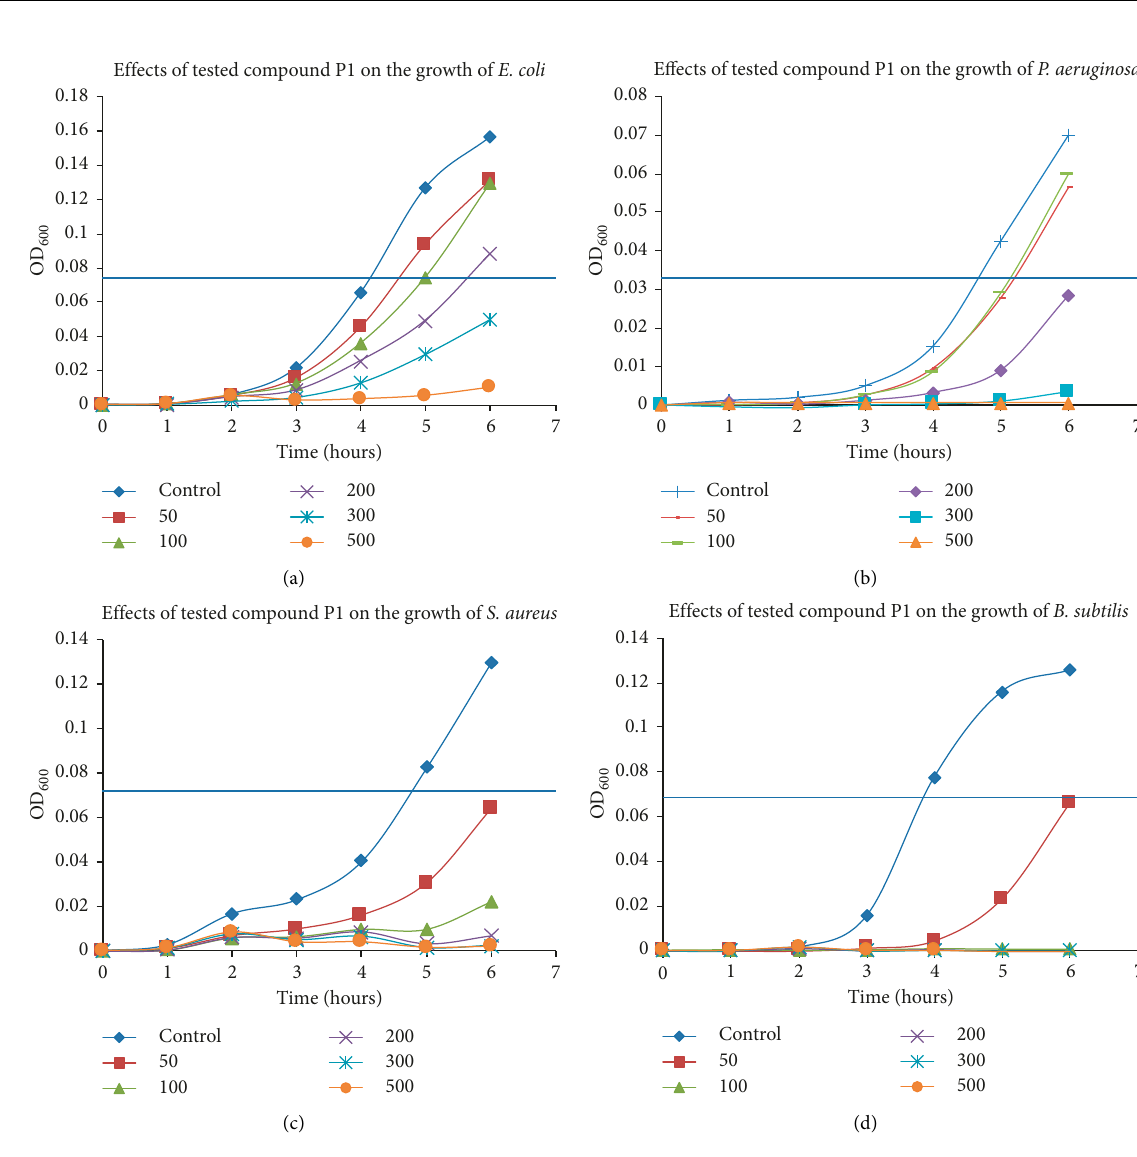
Figure 1: Effects of different concentrations of compound P1 against different time points. All compound concentrations are in µ g/mL.